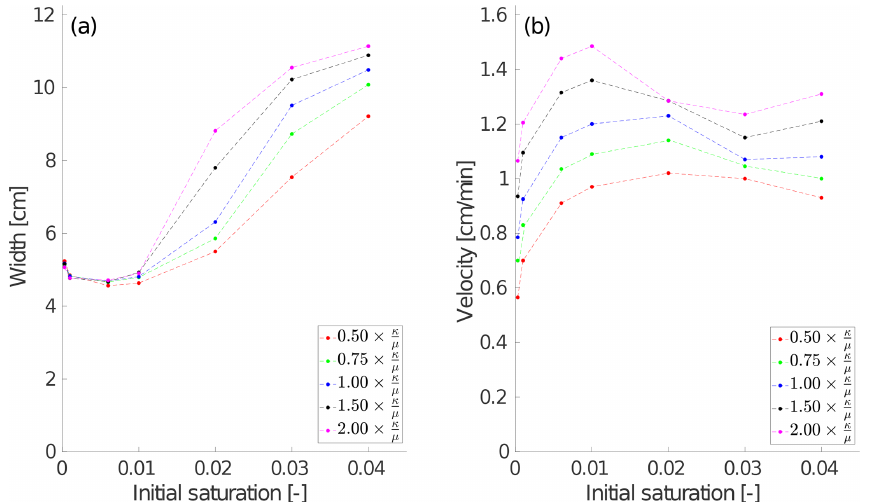
Figure B2. The effect of the intrinsic permeability and dynamic viscosity on the flow regime. The width (a) and the velocity (b) of the finger (or wetting front) at t = 25min is plotted against the initial saturation for five different values of b · κ distributions of the intrinsic permeability is plotted.